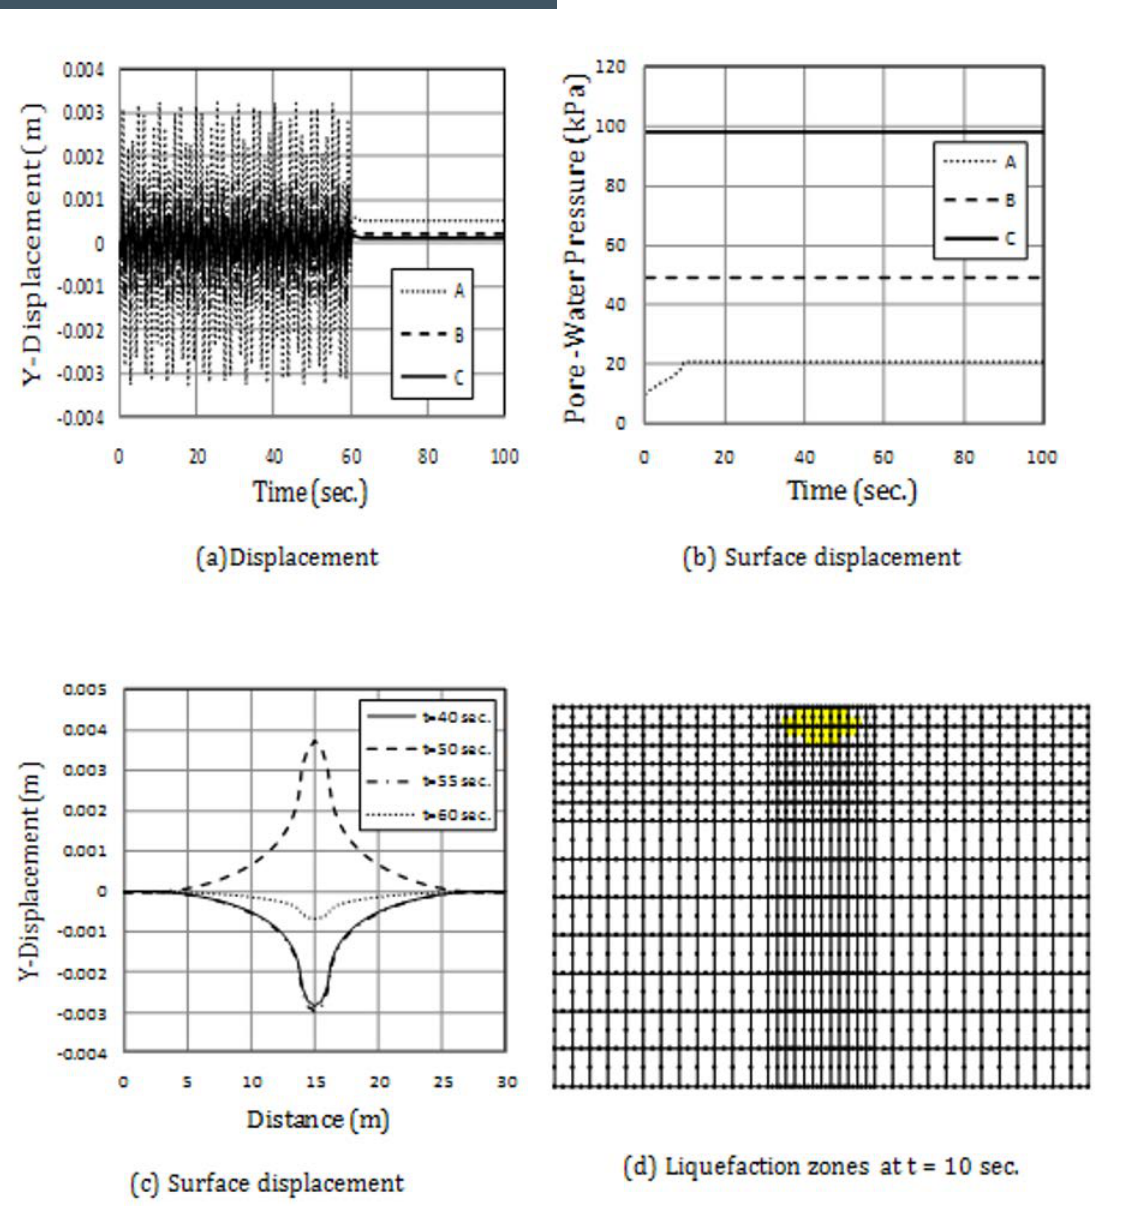
Figure 16. Dynamic response of the foundation to harmonic load, a